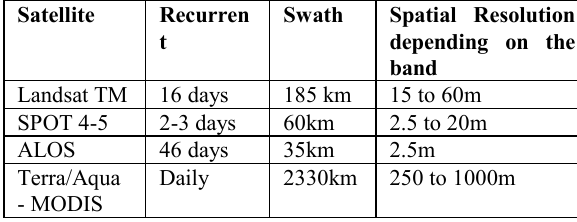
Table 1. A comparison of basic components of four prominent earth observation satellites.